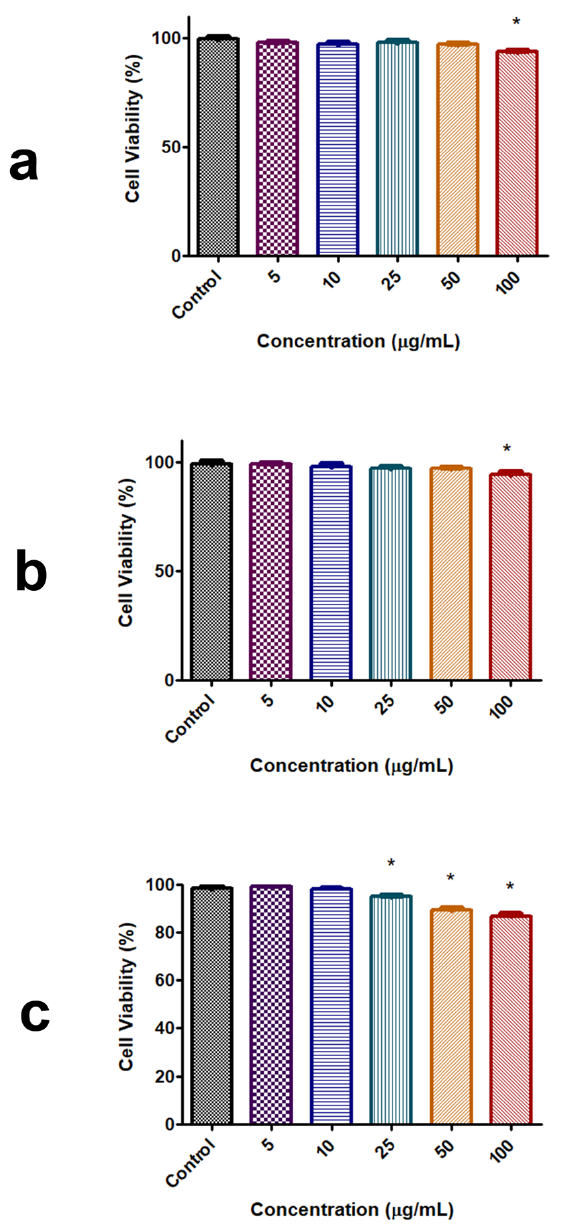
Figure 3. Percentage of viable cells assessed by the MTT assay: (a) Keratinocytes (HaCat), (b) Fibroblasts (ATCC® PCS-201-012 ™) and (c) Macrophages (RAW264.7). Results are Mean Standard deviation of n = 5 determinations. * Mean value is significantly different between Control and test with p <